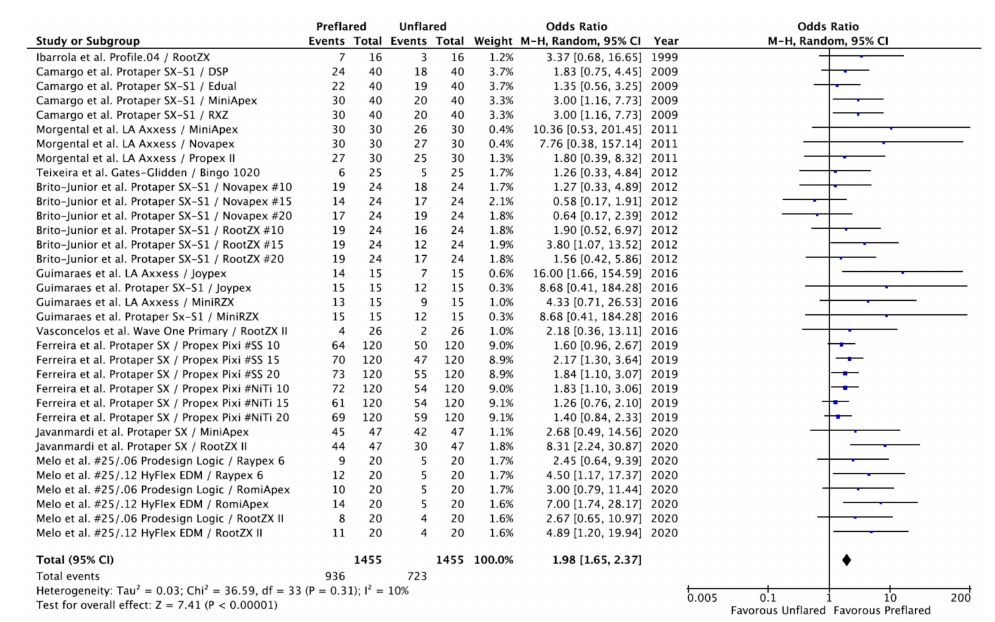
Figure 2. Forest plot of ORs and 95% confidence limits (CL) for the comparison of unflared and preflared canals regarding the accuracy of electronic apex locators (EALs) in working length (WL) determination. The overall estimate is based on the data from the ten included studies. Black squares represent the point estimate of the odds ratio and have areas proportional to study size. Lines represent 95% confidence intervals. The diamond shows the summary statistic for the 34 results from the ten included studies. The solid line indicates an odds ratio of 1.0. OR: odds